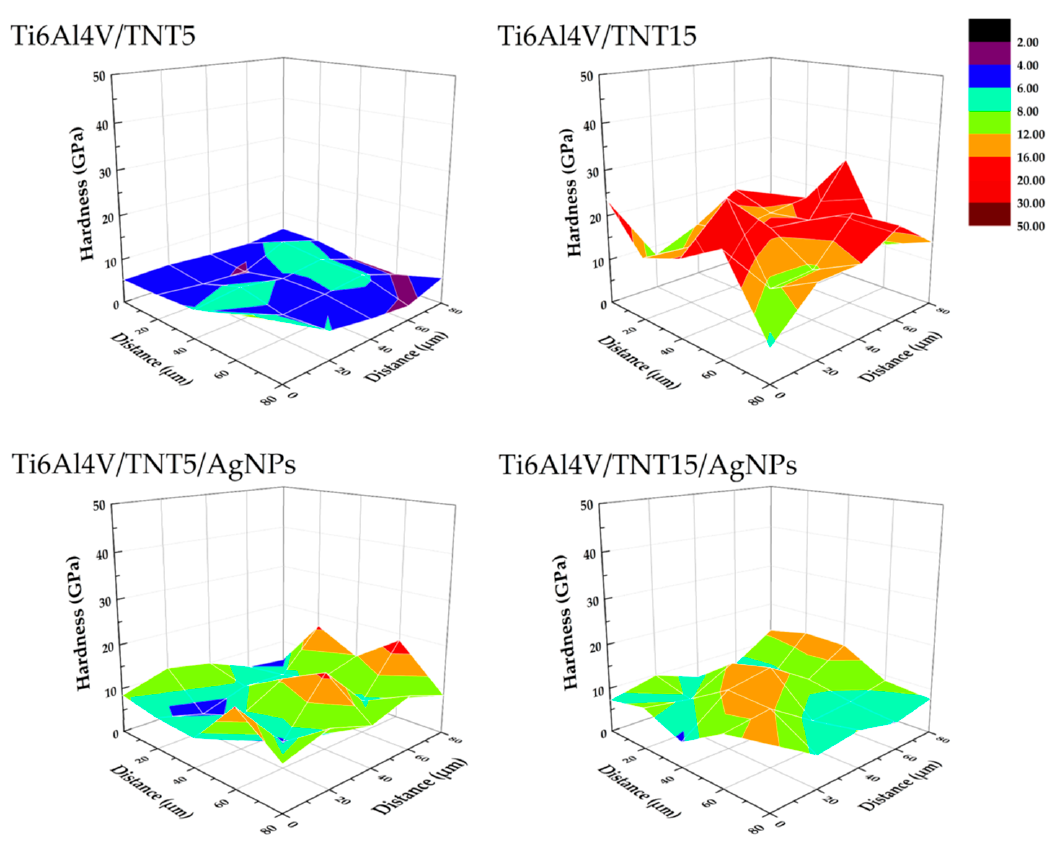
Figure 6. Hardness distribution of Ti6Al4V/TNT5, Ti6Al4V/TNT15, Ti6Al4V/TNT5/AgNPs, and Ti6Al4V/TNT15/AgNPs composites.